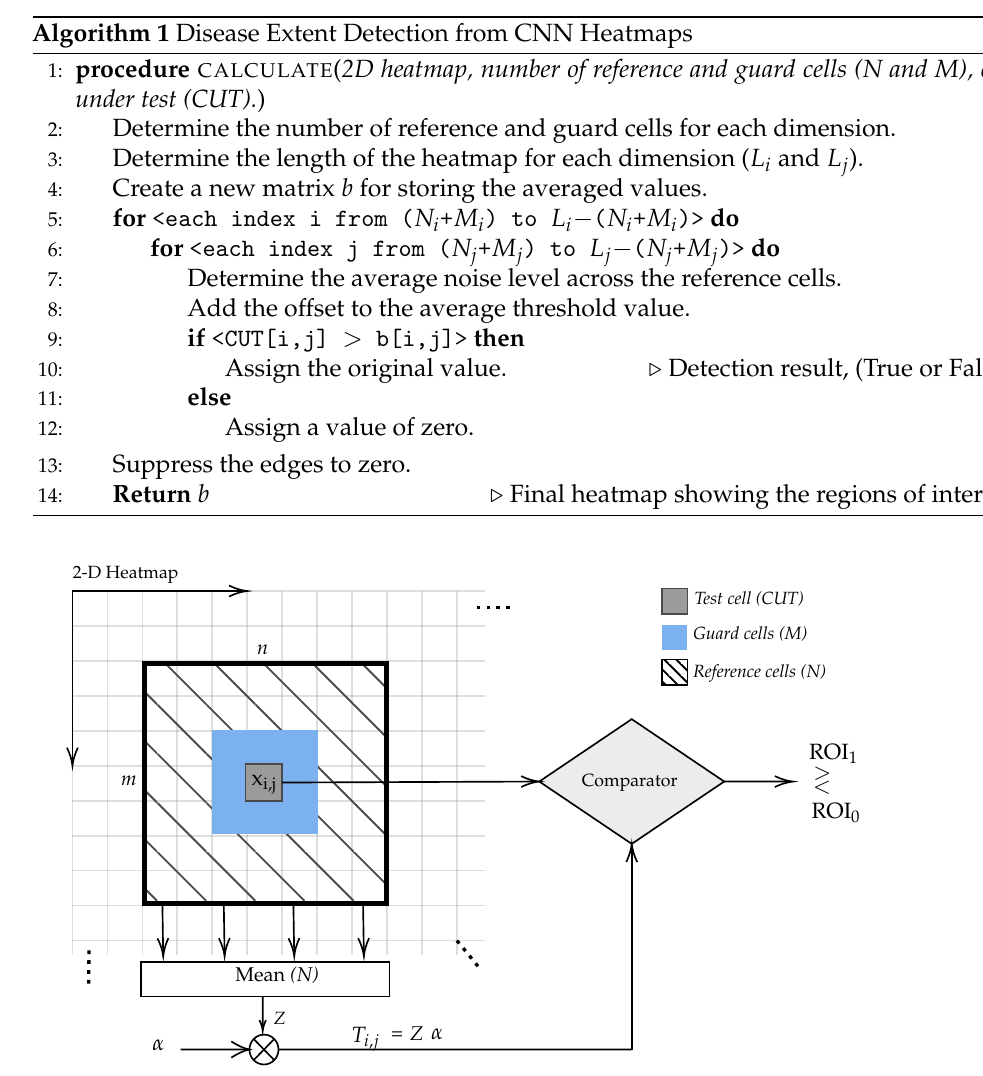
Figure 8. Adaptive threshold computation. The algorithm accepts a 2D heatmap image I and an ( n m ) 2D sliding window that samples the entire region of the heatmap. The sliding window × partitions the heatmap into three regions: (i) test cell, (ii) guard cells and (iii) reference cells. For each test cell or heatmap index x i , j , the algorithm assigns guard cells around the test cell and calculates the average values of the pixels in the reference cells. The resulting mean is then multiplied by a fixed constant α to determine the threshold value for that test cell only. Finally, a comparator compares this threshold with the value of the test cell to determine the presence of an ROI before moving to another heatmap